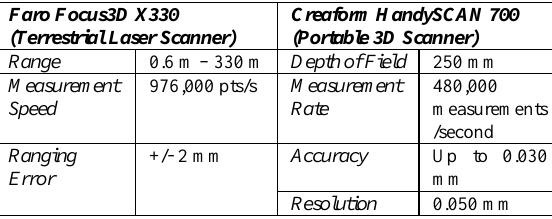
Table 1: Key technical parameters of AMO’s In-house 3D